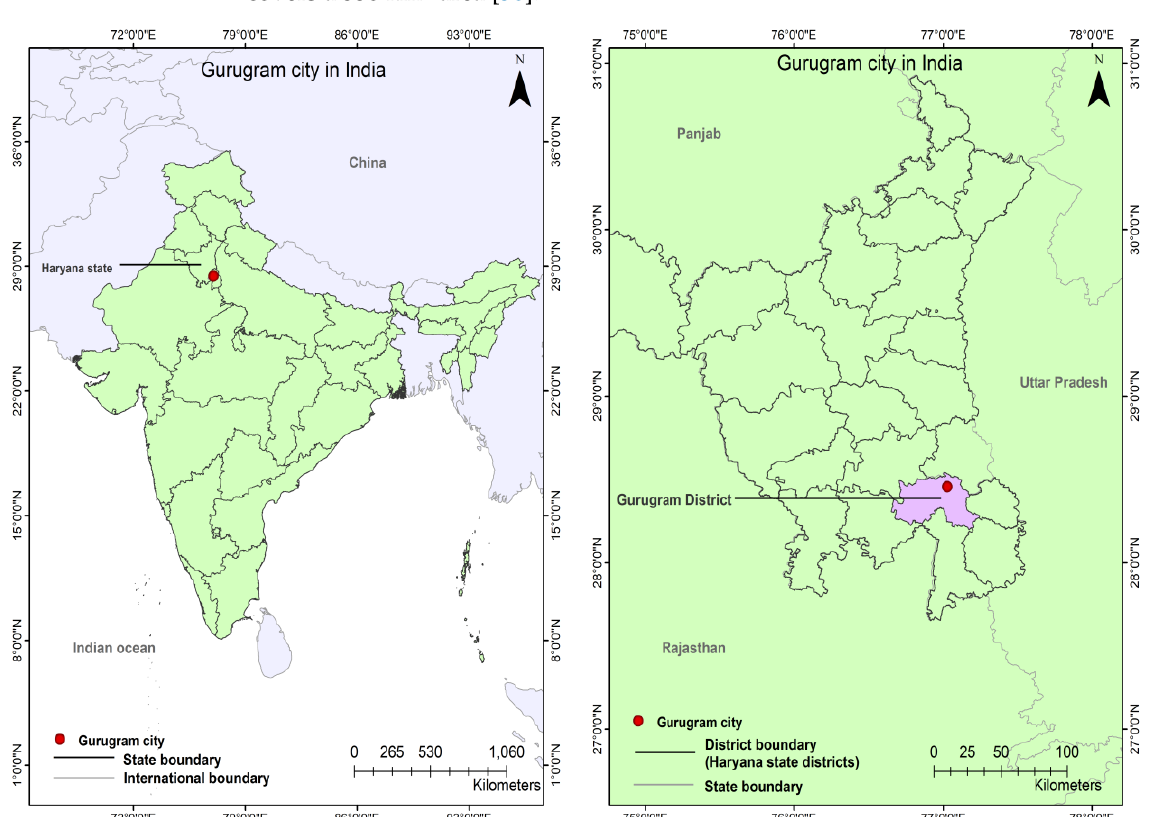
Figure 6. Map showing location of Gurugram city in India (Authors,